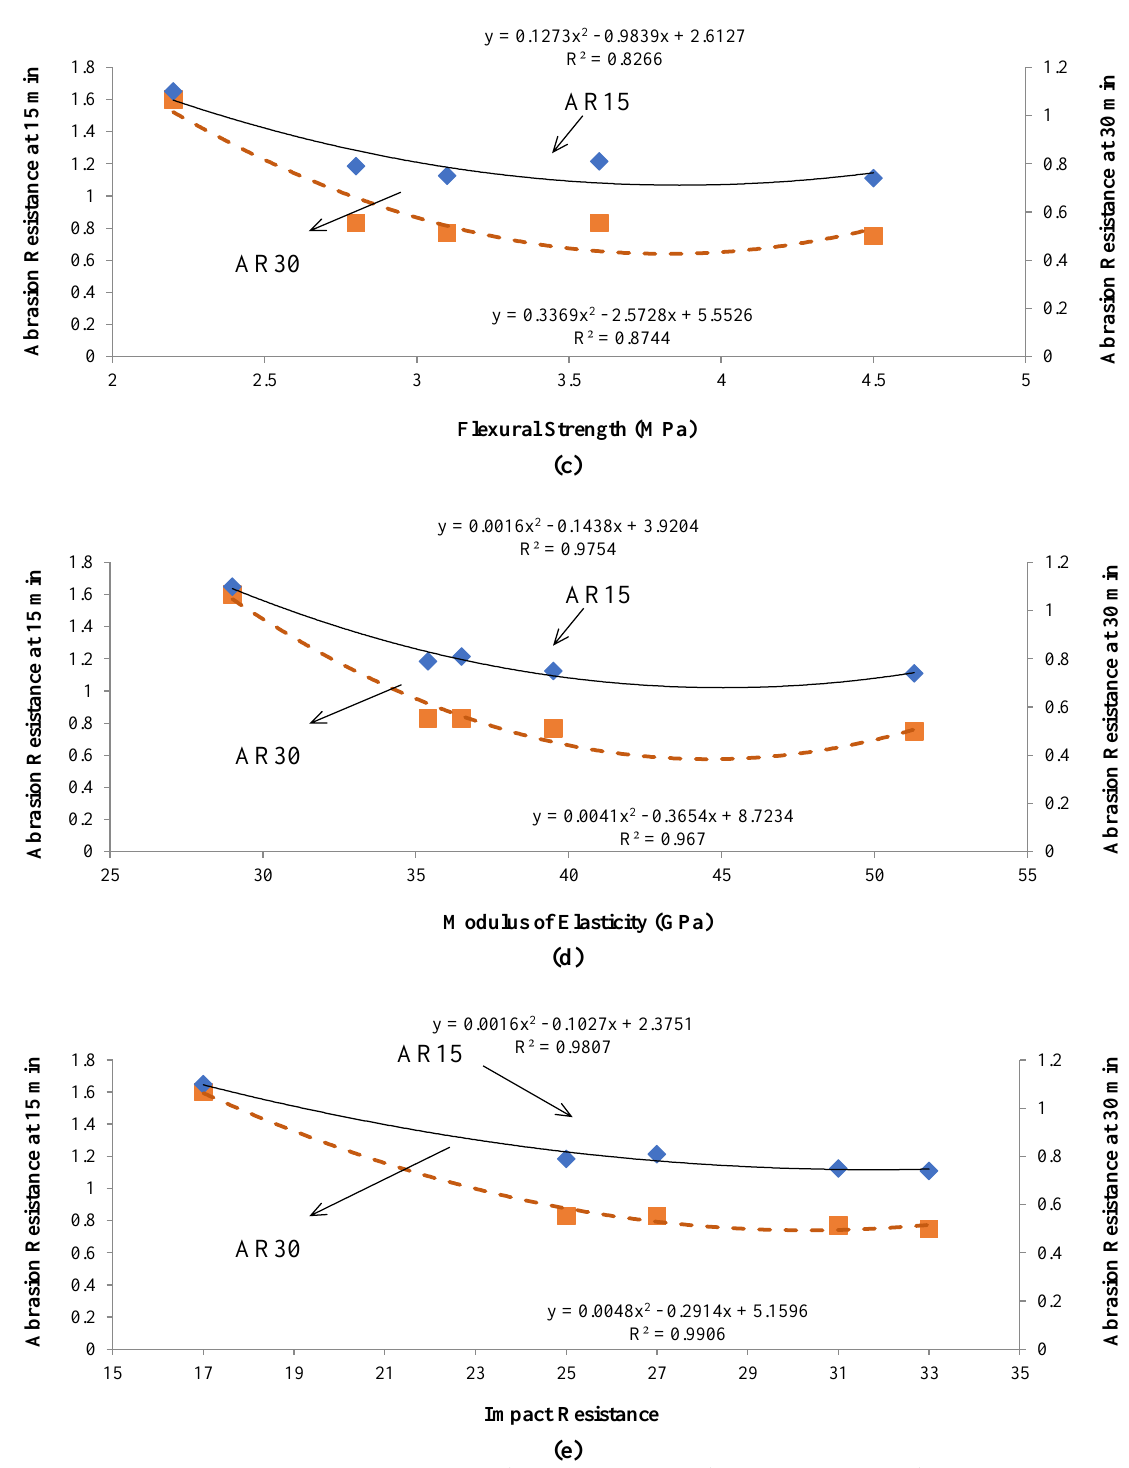
Fig. 6. Relations between compressive strength: a) Tensile strength; b) Flexural strength; c) Elasticity modulus; d) Impact resistance; and e) With abrasion resistance at 15 min/30